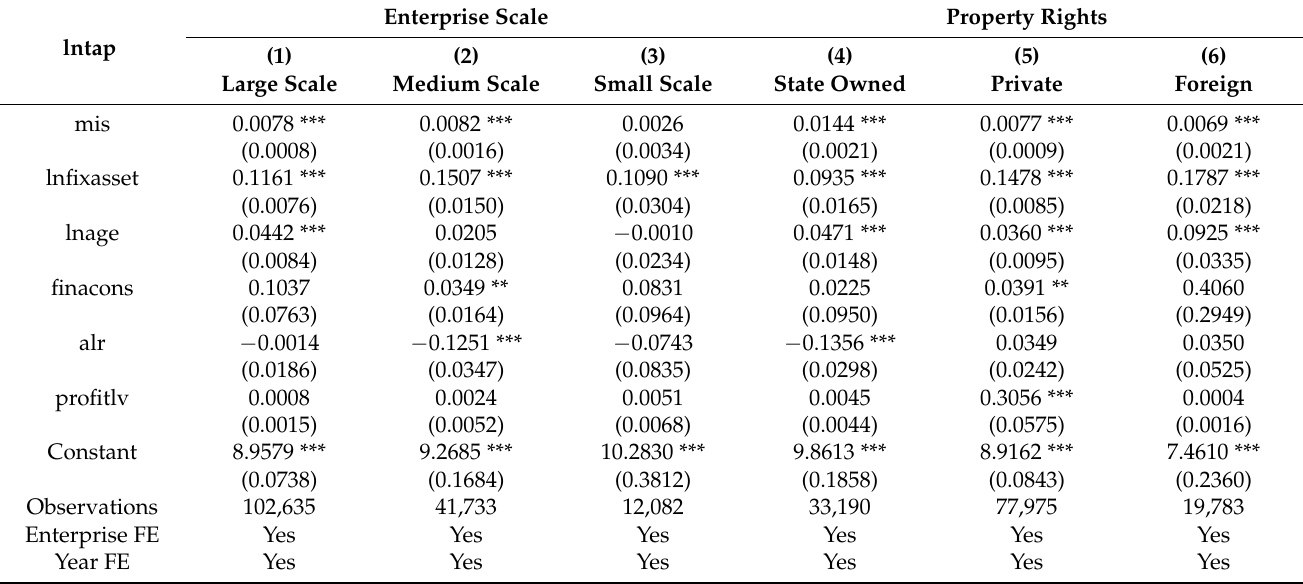
Table 8. Results of heterogeneity analysis of enterprise scale and ownership.